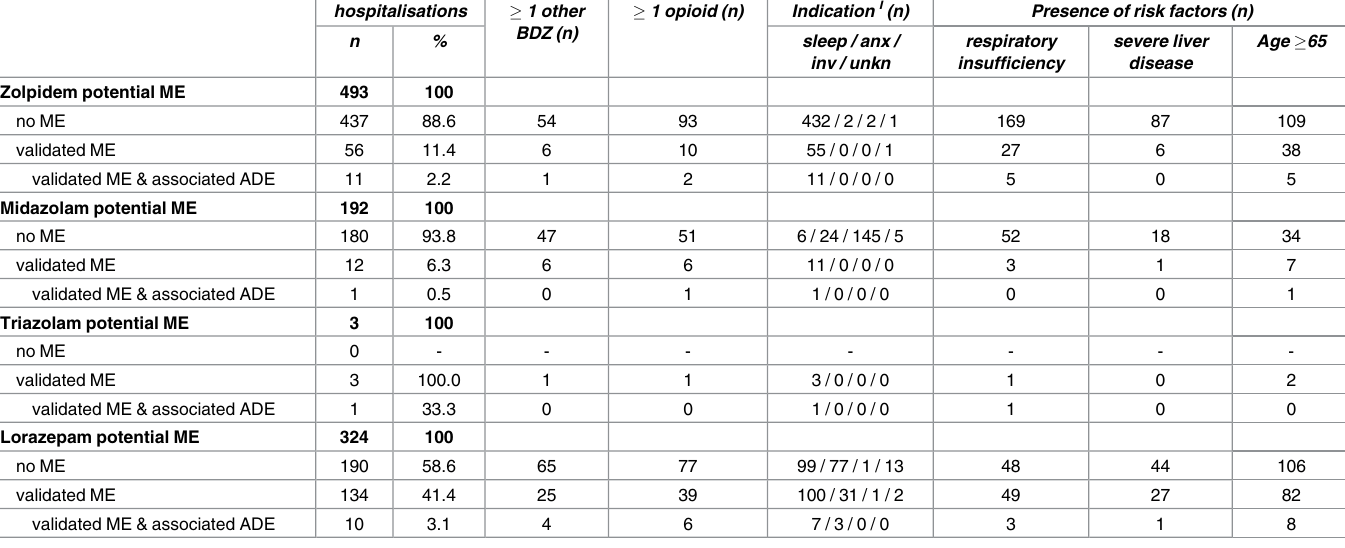
Table 4. Potential and validated ME and associated ADE.